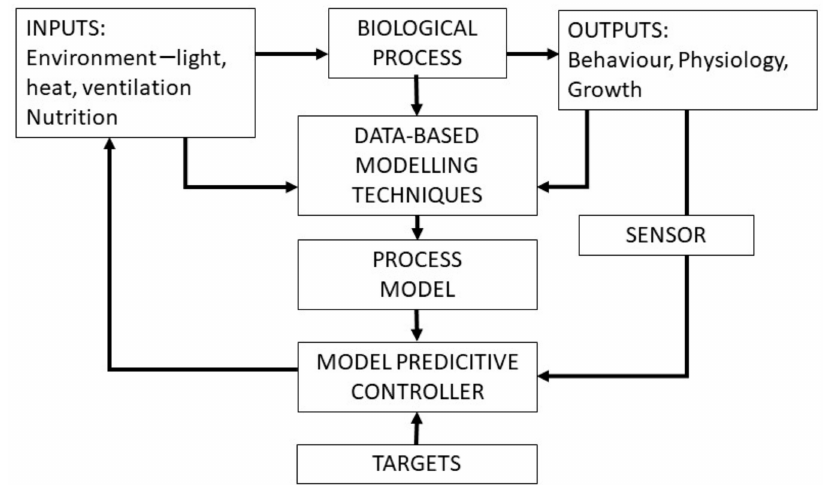
Figure 1. Model of Precision Livestock Farming showing the principal flow of data, the process control where real-time results are compared with a target value, followed by a control function that determines if the information from the sensor matches the target value